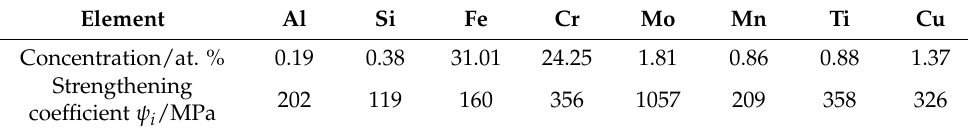
Table 4. Strengthening coefficients for solid solution strengthening in nickel [25,63]. Element Al Si Fe Cr Mo Mn Ti Cu Concentration/at.